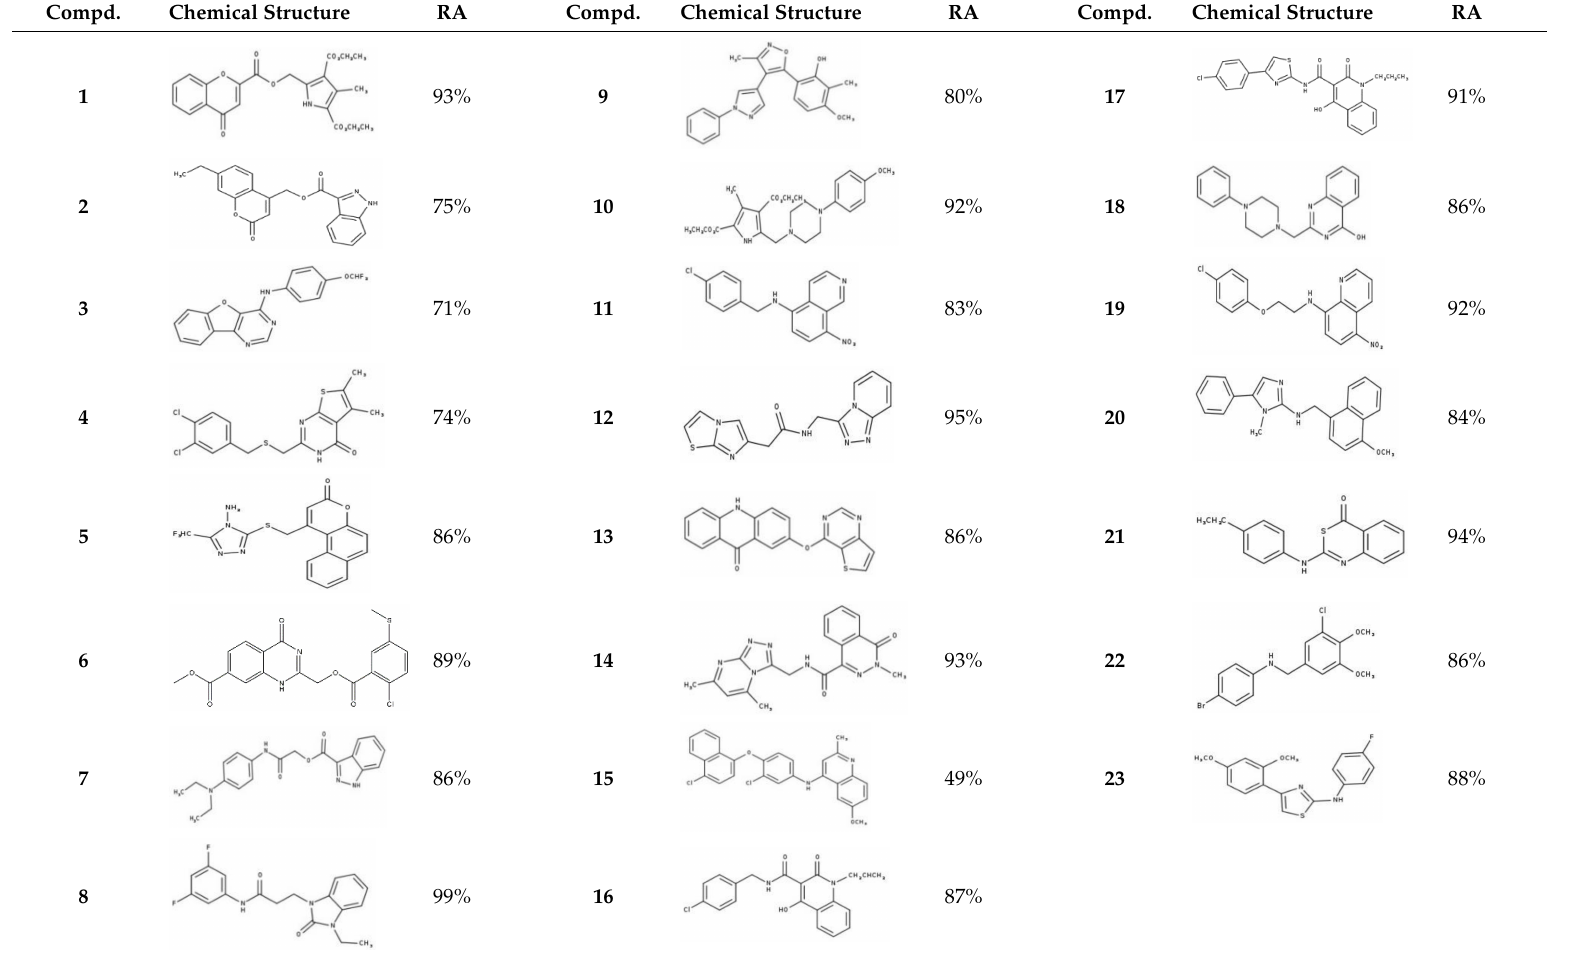
Table 2. Results of the inhibition assays of the selected hit compounds 1 – 23 derived from the virtual screening campaign against Li NDH2, expressed as relative activity (RA) of the NDH-2 from S. aureus . RAs in % at 20 µ M compound concentration were calculated considering the activity in the absence of any inhibitor as 100%. Compd.